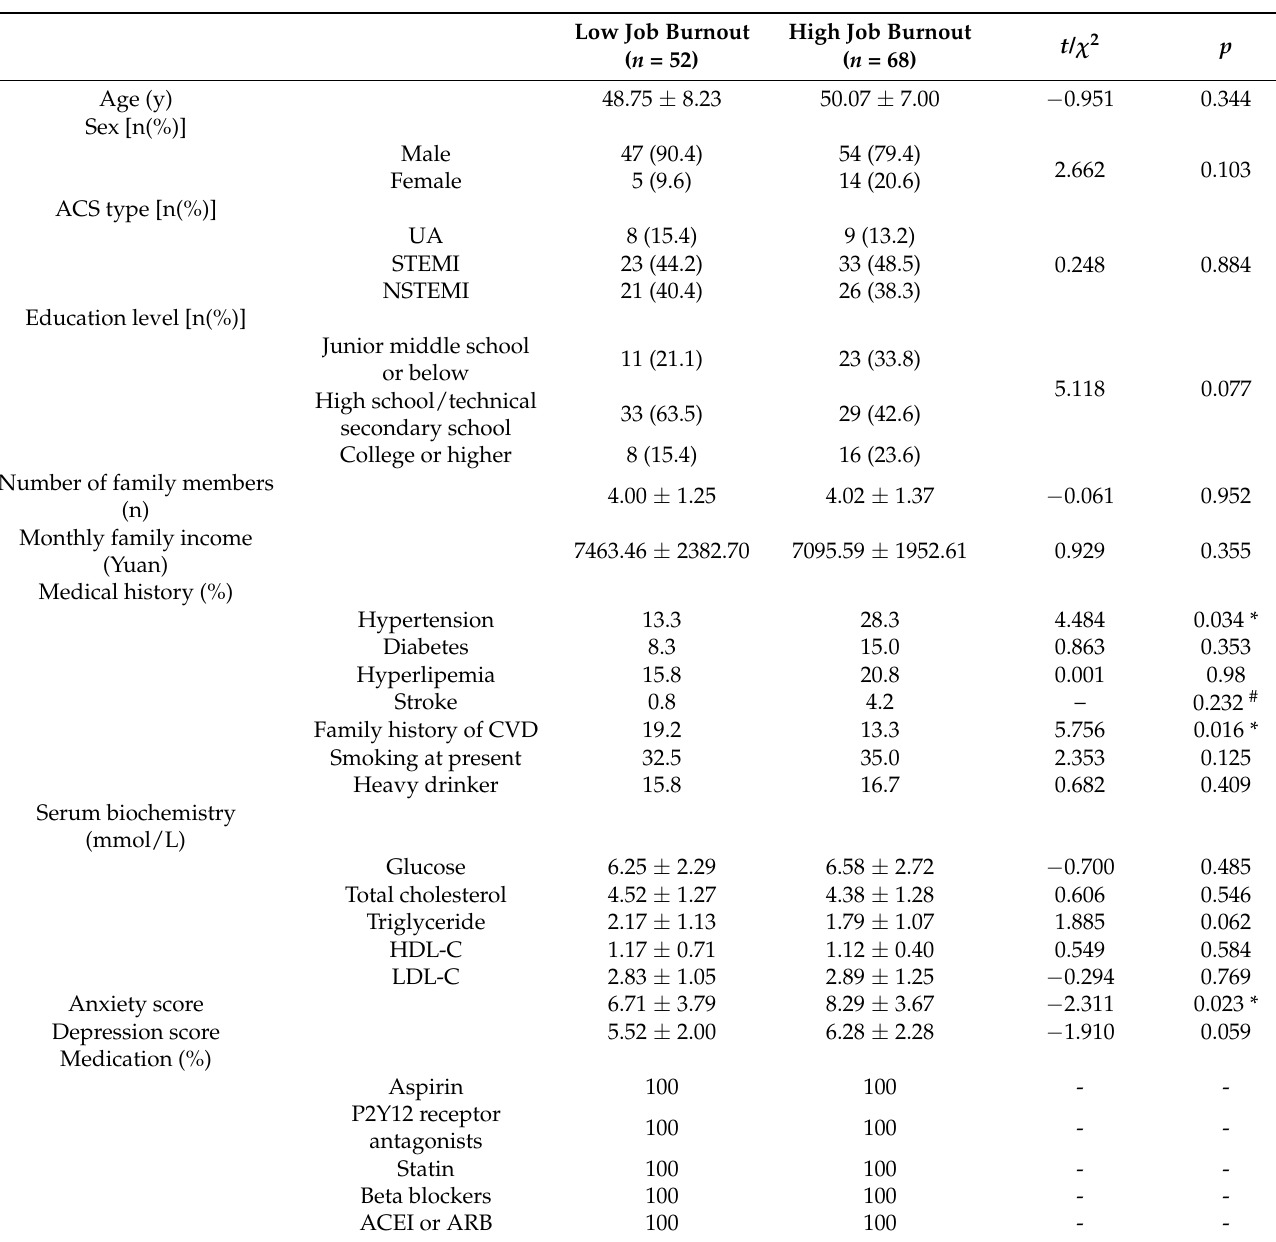
Table 1. Characteristics of study participants at baseline ( n =